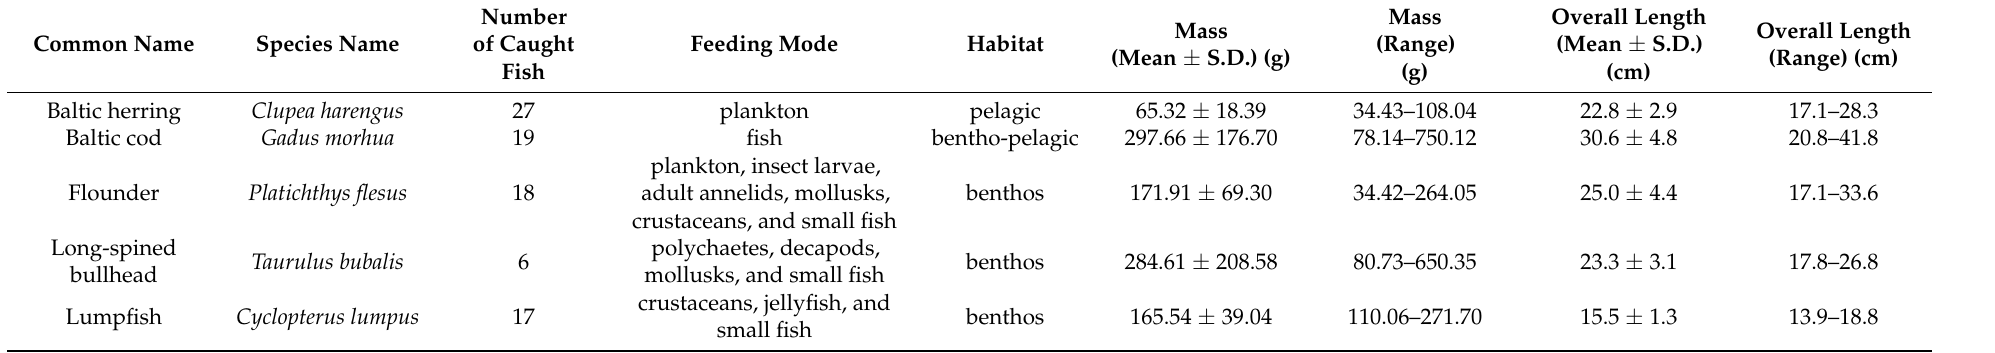
Table 1. Characteristics of different fish species caught as by-catch at the 108 and 103 FAO fishing